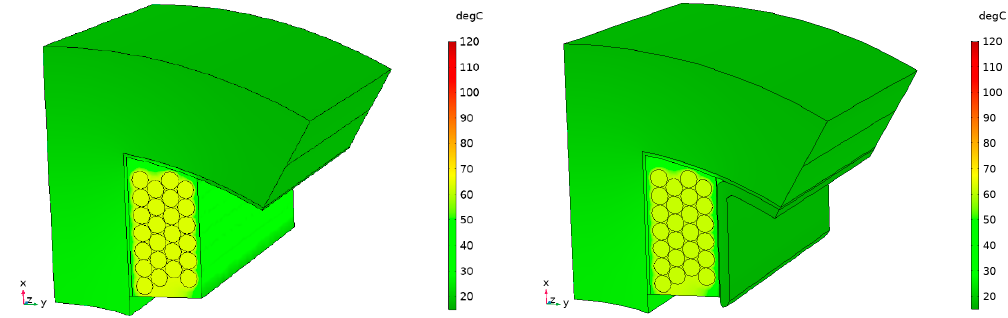
Figure 8. Temperature distribution for WJ1 + DCC1 ( left ) and WJ2 + DCC2 ( right ).